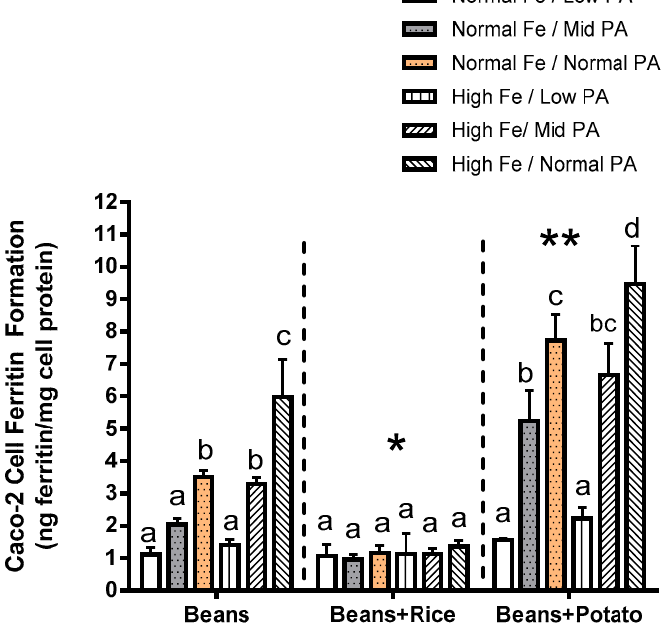
Figure 1. Experiment 2. Iron uptake as measured by Caco-2 cell ferritin formation from beans pre-treated with phytase. Values represent Fe uptake from normal or high Fe beans with normal phytate (PA; 100%) levels, or PA levels reduced to low (34%) or mid (68%) of the normal PA content. Bar values within food combination groups with no letters in common are significantly different ( p < 0.05). A single asterisk indicates significant inhibitory effect ( p < 0.05) of the addition of rice, whereas the double asterisk indicates significant promotional effect of the addition of potato.